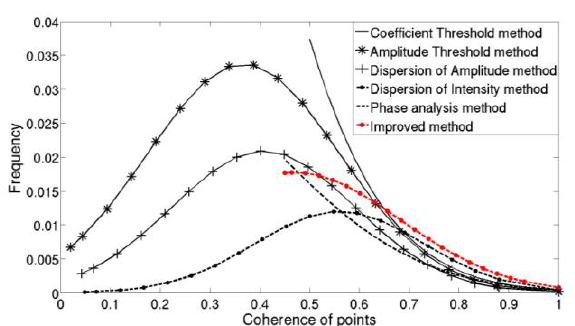
Figure 4. Coherence histogram of PS points